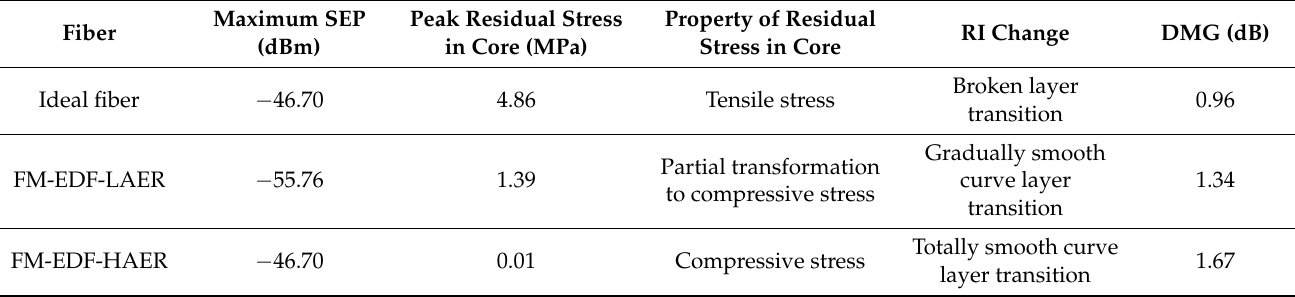
Table 1. Influence of fiber residual stress on the MGE of